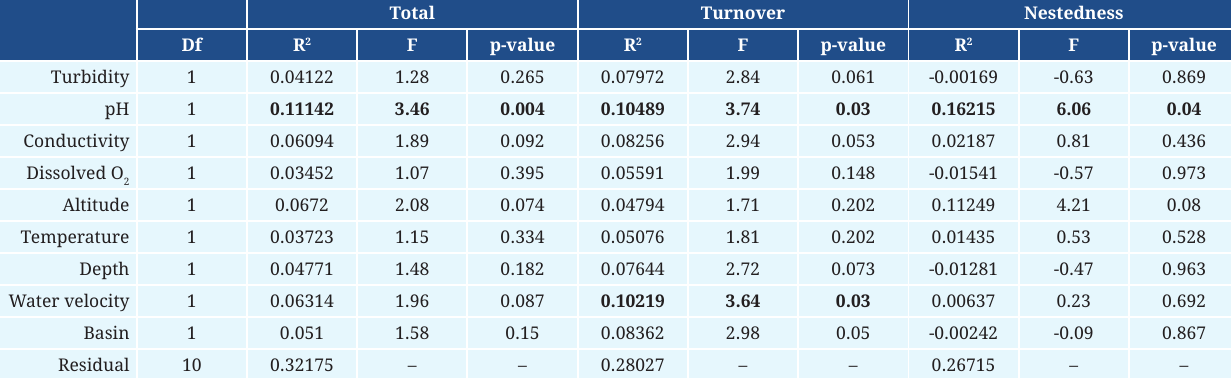
TABLE 3 | Results from adonis2 analysis relating different components of phylogenetic beta diversity and environmental variables.